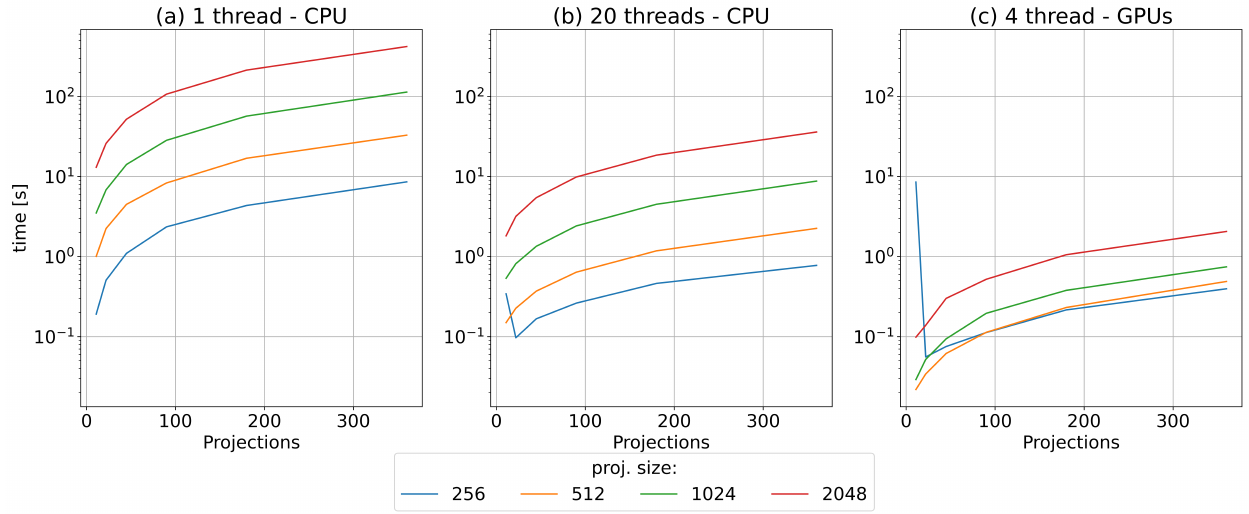
Figure 6. Performance comparison for the warp module, shown for single-thread (first column), 20 threads (centre column), and a multi-GPU implementation (third column). The performance gain in terms of speed is large even for the CPU-only multi-threaded solution.